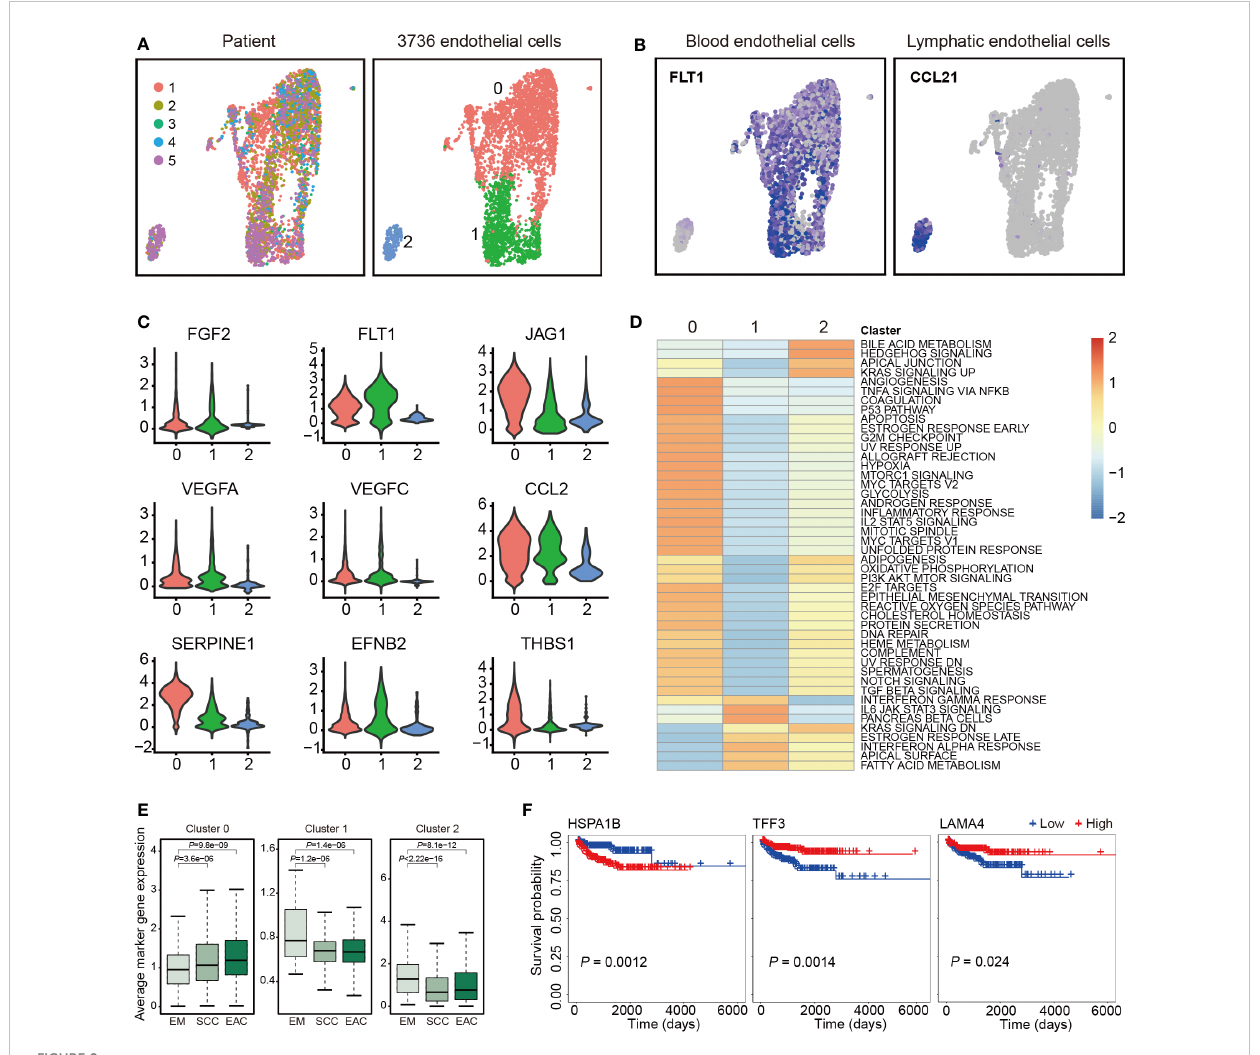
FIGURE 2 Endothelial cell clusters. (A) Uniform manifold approximation and projection (UMAP) plot of 3,736 endothelial cells, color-coded by their corresponding patient (left) or associated cluster (right). (B) UMAP plot color-coded for expression (blue to gray) of marker genes for blood and lymphatic endothelial cells. (C) Violin plots of selected genes involved in angiogenesis. (D) Differences in pathway activities scored per cell by GSVA between the different clusters. Shown are t values from a linear model. (E) Average expression of the marker genes for endothelial cells from each cluster in TCGA samples from endometrium (EM, n = 35), serous cystadenocarcinoma (SCC, n = 133) or endometrioid adenocarcinoma (EAC, n = 401). (F) The three marker genes associated with overall survival of endometrial carcinoma patients in